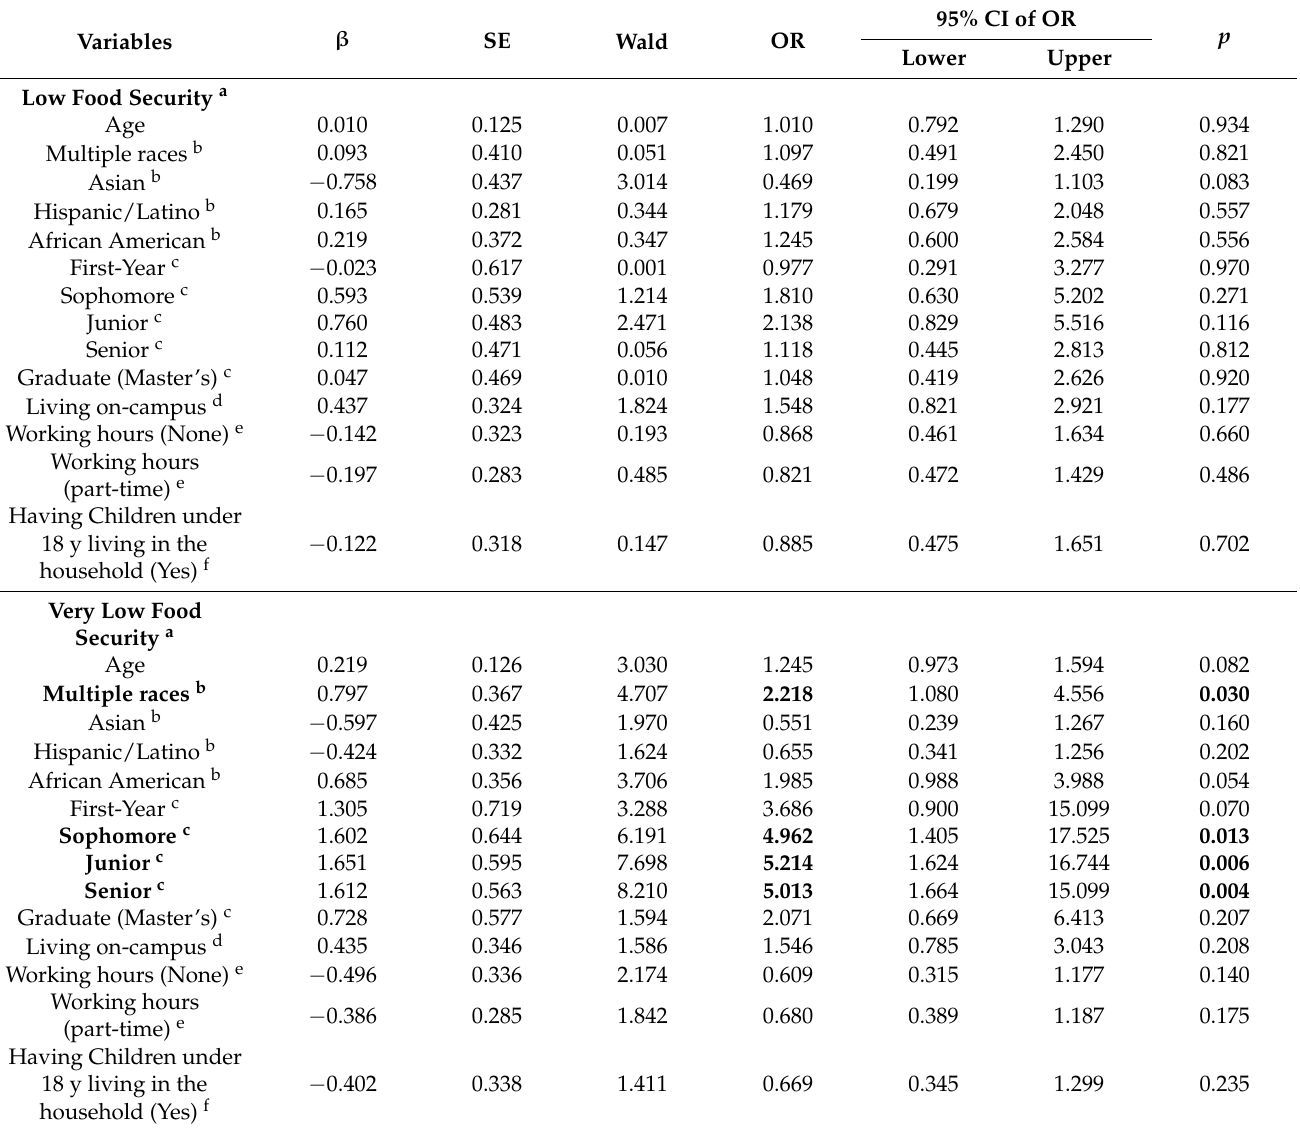
Table 2. Summary of Multinomial Regression Predicting Food Security According to Demographic and Other